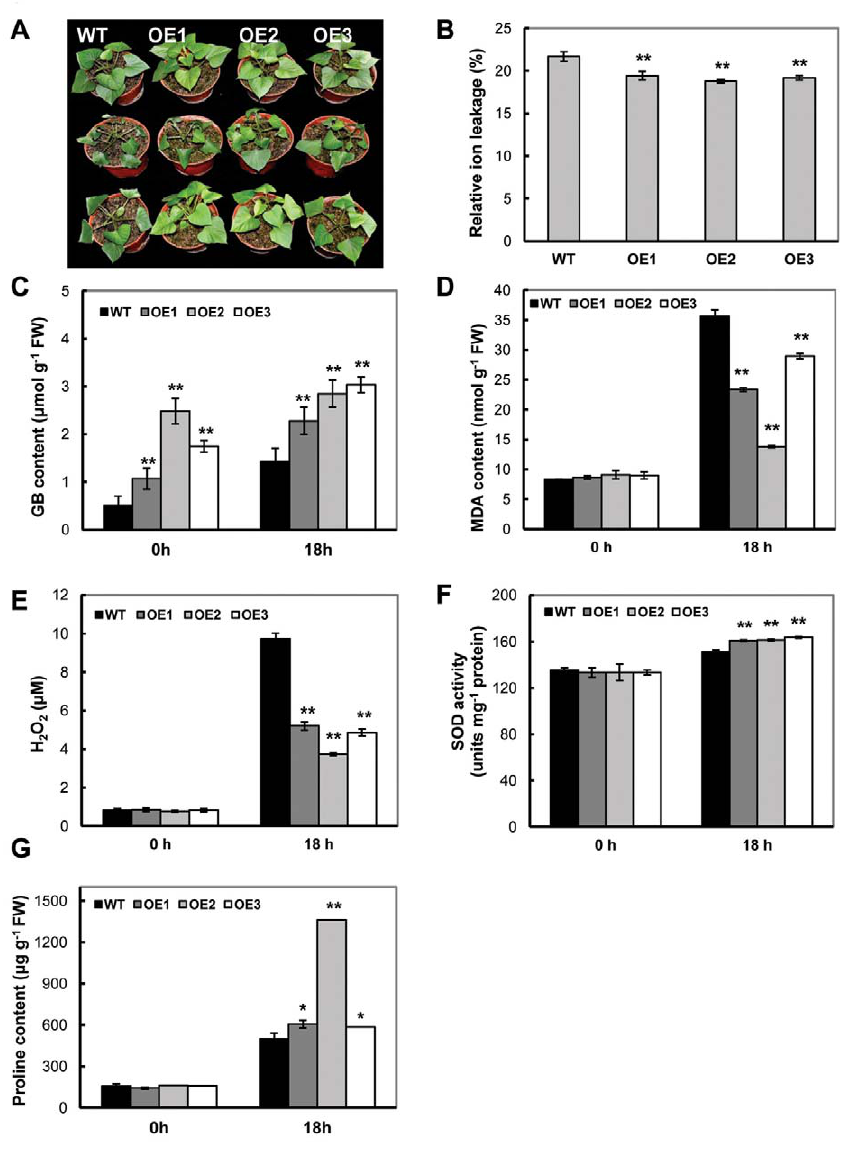
Figure 6. Phenotypic and physiological analyses of the SoBADH transgenic plants under cold treatment. A, phenotypic changes before (upper panel) and after (middle panel) cold treatment (4 u C for 18 h) and the recovered phenotype (lower panel); B, decreased ion leaking in the cold- treated leaf discs of OE plants than that of WT; C, contents of GB in the leaves of transgenic and WT plants after cold treatment; D–E, MDA and H 2 O 2 contents in the leaves of the transgenic and WT plants; F, changes of SOD activity in transgenic and WT plants after cold treatment. G, proline contents in the leaves of the transgenic and WT plants after the treatment. Values represent the mean 6 SD (n=9). Asterisks indicate a significant difference from that of WT at * P , 0.05 or ** P , 0.01 by t -test.